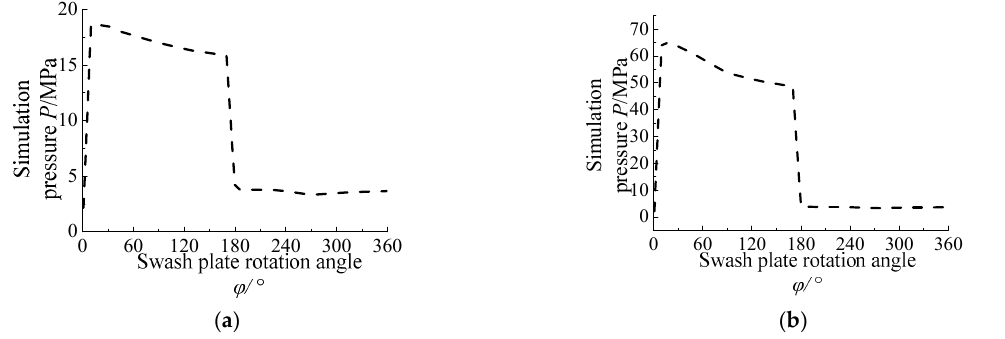
Figure 15. This figure is the simulation result: ( a ) Simulation curve of oil film pressure with load pressure of 20 MPa; ( b ) simulation curve of oil film pressure with load pressure of 70 MPa.